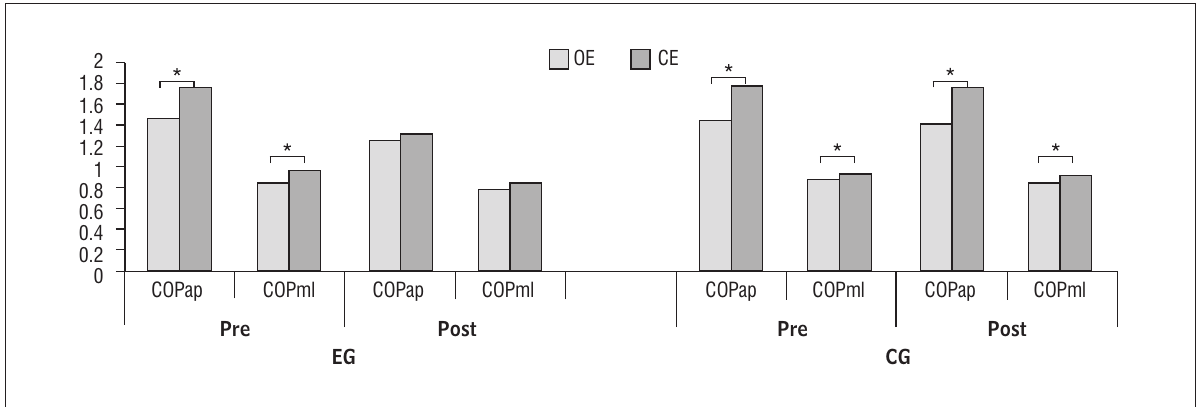
Figure 3 - Results related to visual comparisons (OE x CE) for both groups (CG and EG), in pre and post-training, for both variables analyzed (COPap and COPml)